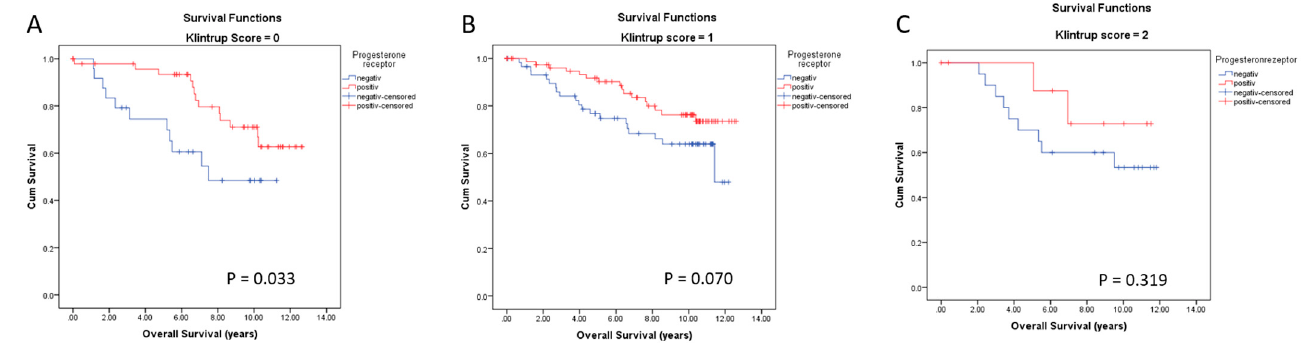
Figure 10. Kaplan–Meier survival analyses for progesterone receptor (PR) in relation to the level of peritumoral inflammation with no inflammatory cells at the invasive margin (Klintrup Score 0 ( A )), mild and pathy increase of inflammatory cells (Klintrup Score 1( B )) and increased inflammatory cells (Klintrup Score 2 ( C )) on overall survival (OS).